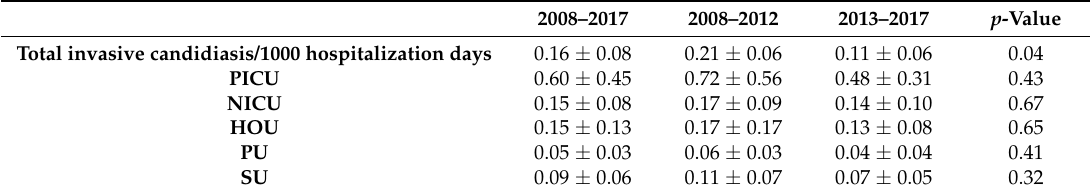
Table 3. Comparison of invasive candidiasis rates per 1000 hospitalization days during the study period